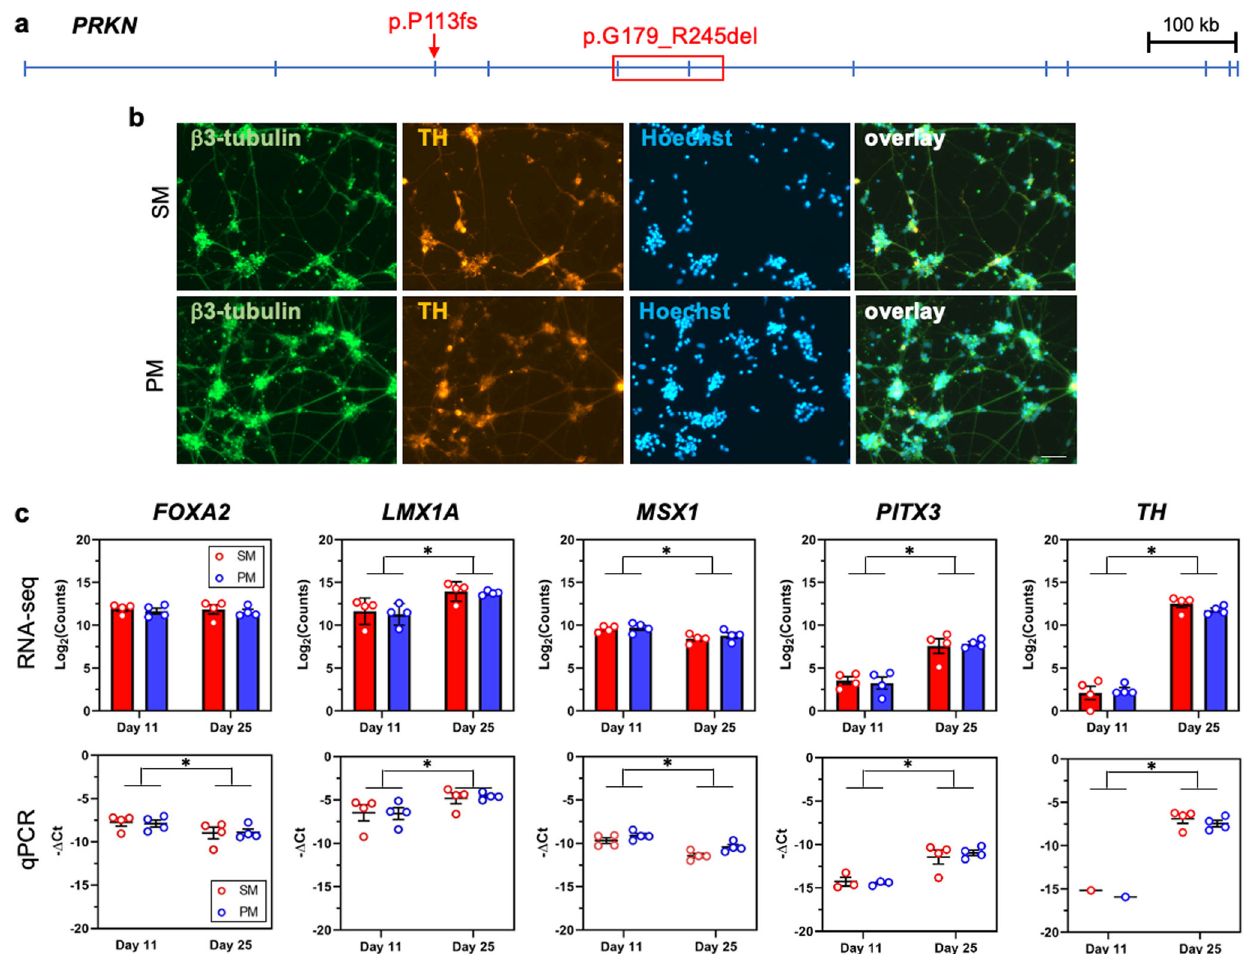
Fig. 1 Differentiation of SM and PM hiPSC into dopamine neurons. a PRKN gene, transcript variant 1 that encodes a 465 amino acid protein, is shown with the compound heterozygous mutations identi fi ed in the brothers: p.P113fs in exon 3 and p.G179_R245del that spans exons 5 and 6. b The expression of β 3-tubulin (green) and tyrosine hydroxylase (TH, red) of dopamine neurons differentiated for 27 – 28 days was assessed by immunocytochemistry. All cultures were counterstained with the nuclear Hoechst stain (light blue). Shown here are cell lines SM15 and PM18, scale bar = 50 µm. c mRNA of dopamine neuron lineage markers expressed by day 11 and day 25 SM (red) and PM (blue) neuronal cultures derived from four SM- and PM hiPSC lines each were quanti fi ed by RNA-seq and RT-qPCR. RNA-seq counts were multiplied by a factor of 100 to accommodate logarithmic scaling on the y-axis of the graphs. On day 11 1/4 (PITX3) and 3/4 (TH) of the samples for SM and PM were below the threshold of RT-qPCR detection and are thus not depicted on the graphs. Except for FOXA2 (RNA-seq), the expression levels for all dopamine neuron markers were statistically signi fi cantly different between day 11 and day 25, but were not signi fi cantly different between SM and PM for RT-qPCR and RNA-seq. Two-way ANOVA followed by Sidak ’ s multiple comparisons post-hoc test (mean ± SEM; p * <